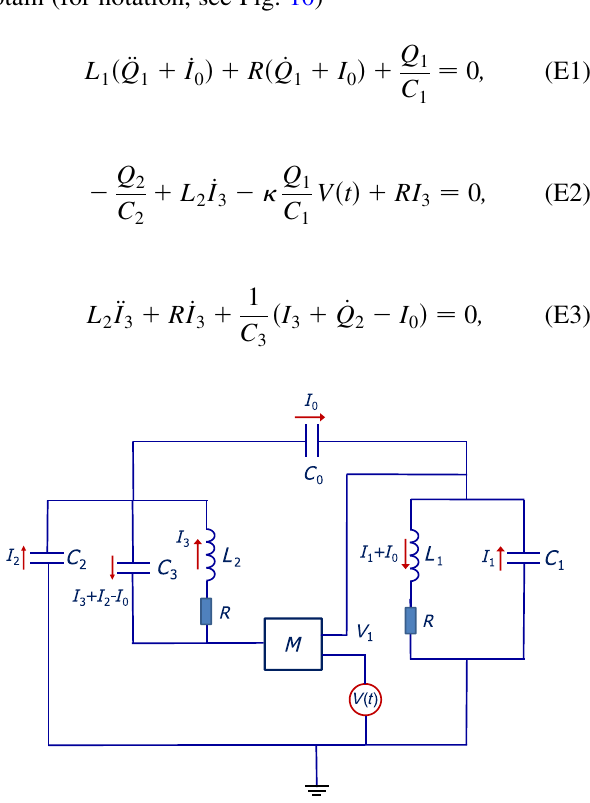
FIG. 10. Electronic circuit analog of the QASER. Two LC circuits weakly coupled by a capacitor C 0 correspond to the atoms and to the field. Modulation of the coupling strength is provided by a feedback mechanism in which voltage V 1 from the capacitor C 1 is applied to the input terminal of the multiplier M ; its output voltage V out is proportional to the product of the two input voltages V ð t Þ and V 1 , where V ð t Þ ¼ V 0 sin ð (cid:3) voltage produced by a function